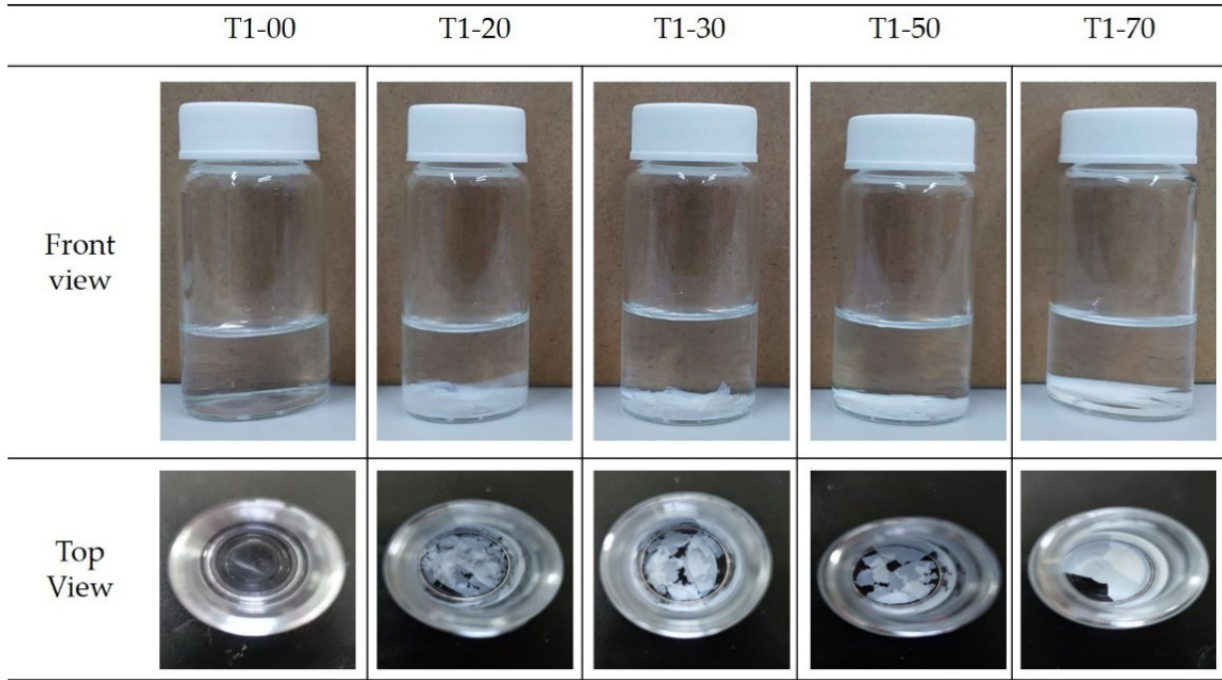
Figure 3. Solvent resistance of SPE membranes.